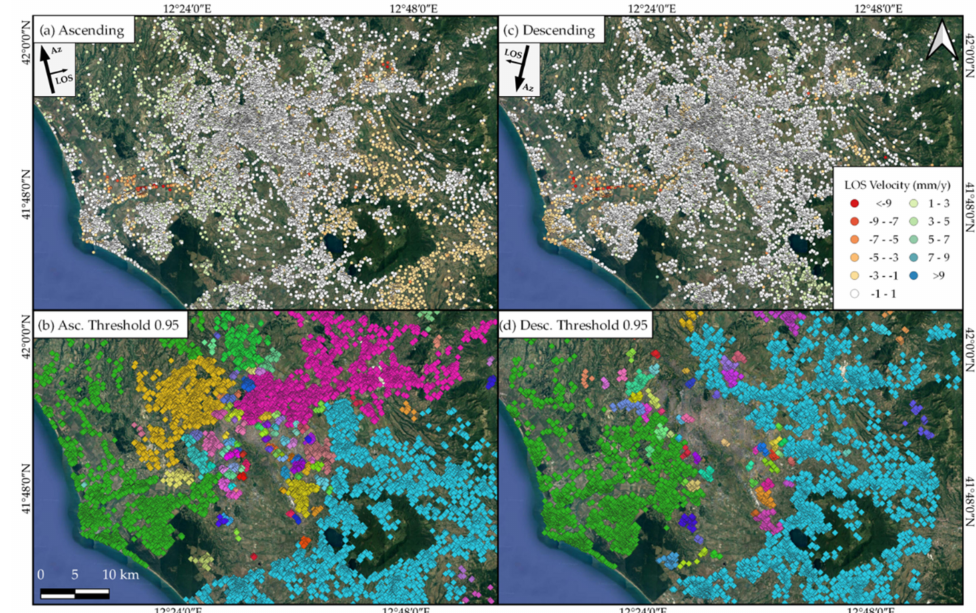
Figure 14. The metropolitan area of Rome with: PS distribution in ( a ) ascending mode and ( c ) descending mode (colour code indicates different LOS velocity ranges), and their subdivision into families with CAPS method by using as threshold 0.95 in ( b ) ascending and ( d ) descending (different colours indicate different PS